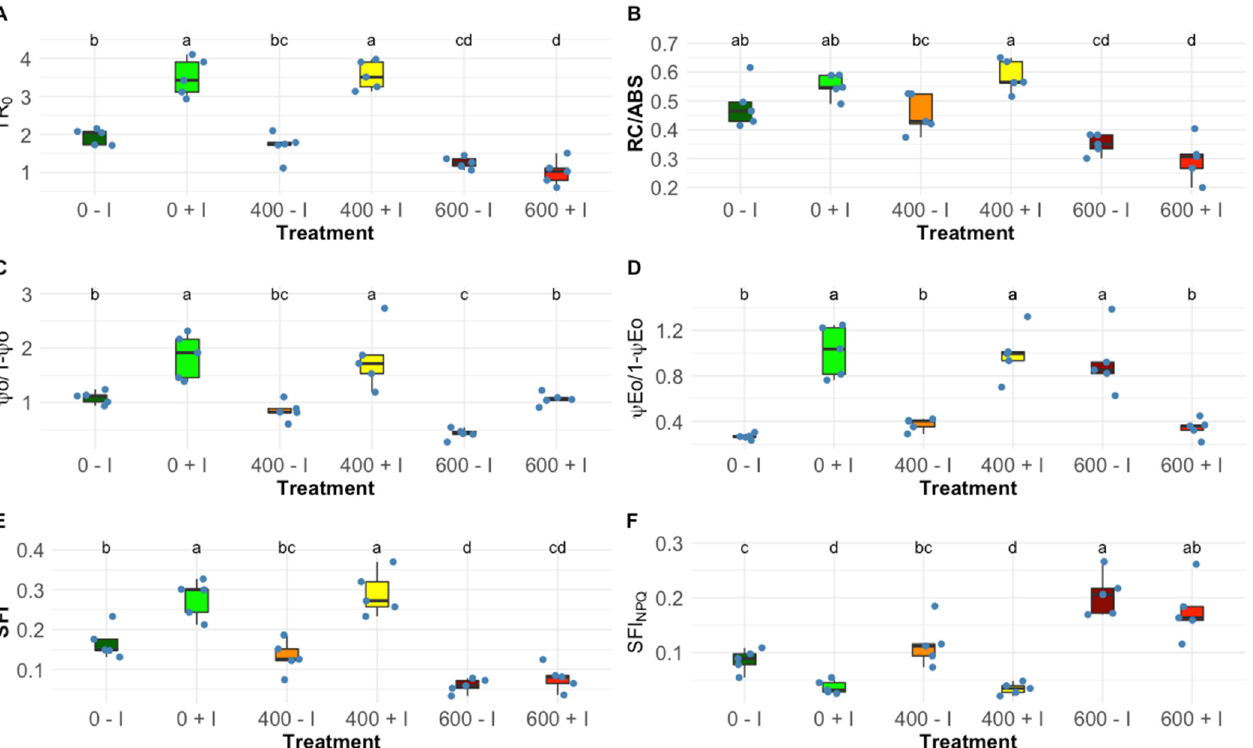
Figure 2. OJIP ‐ derived parameters, ( A ) contribution or partial performance due to the light reactions for primary photochemistry (TR 0 /DI 0 ), ( B ) reaction centre II density within the antenna chlorophyll bed of PS II (RC/ABS), ( C ) the contribution of the dark reactions from quinone A to plastoquinone ( ψ 0 /(1 − ψ 0 )), ( D ) the equilibrium constant for the redox reactions between PS II and PS I ( ψ E0 /(1 − ψ E0 )), ( E ) structural and functional index for photosynthesis (SFI) and ( F ) non ‐ photosynthetic or dissipation structural and functional index (SFI NPQ ) in non ‐ inoculated and inoculated Halimione portulacoides dark ‐ adapted leaves (N = 5), along with the tested NaCl concentrations. Letters indicate significant differences between treatments at p < 0.05.